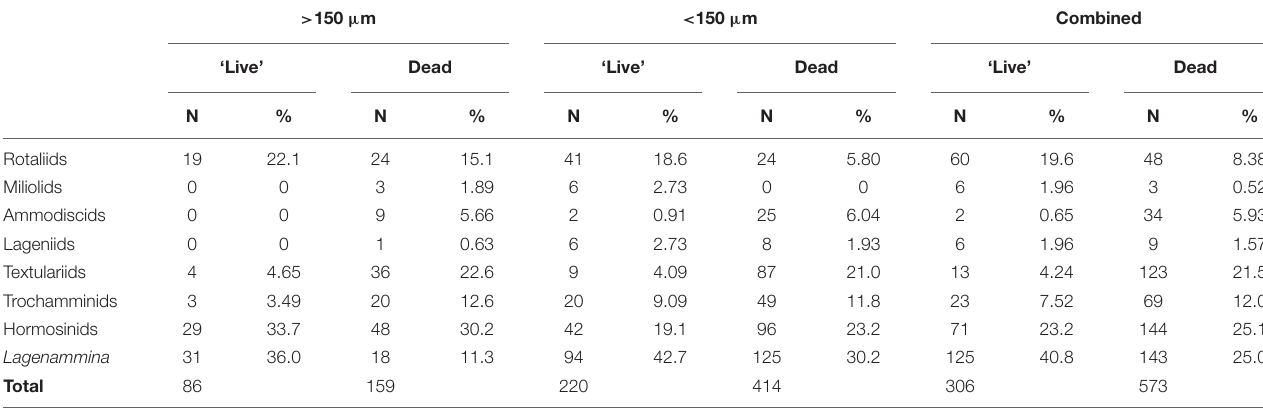
The numbers are totals from all 5 samples. L = ‘Live’ (stained); D = Dead.